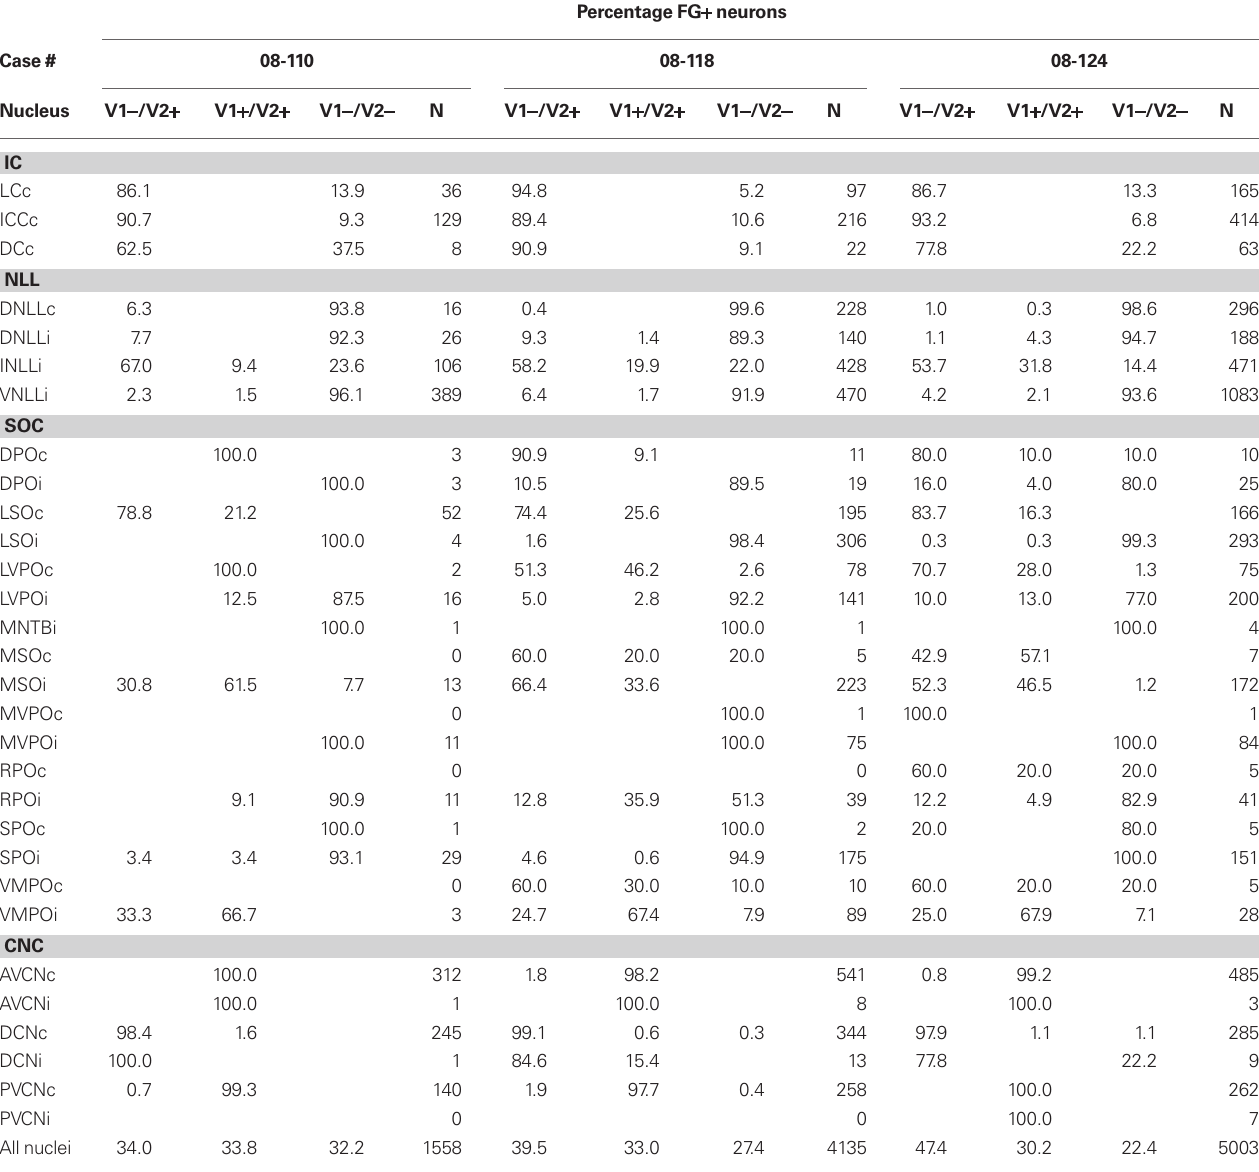
Table 1 | The percentage and number of Fg-positive neurons that express VgLuT1 (V1) and/or VgLuT2